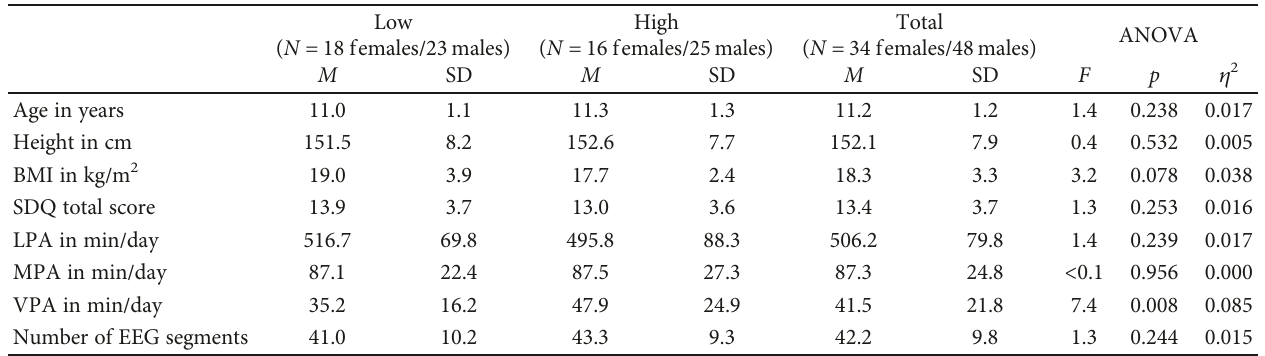
Table 1: Comparison of anthropometric data, psychopathology, and physical activity between groups.